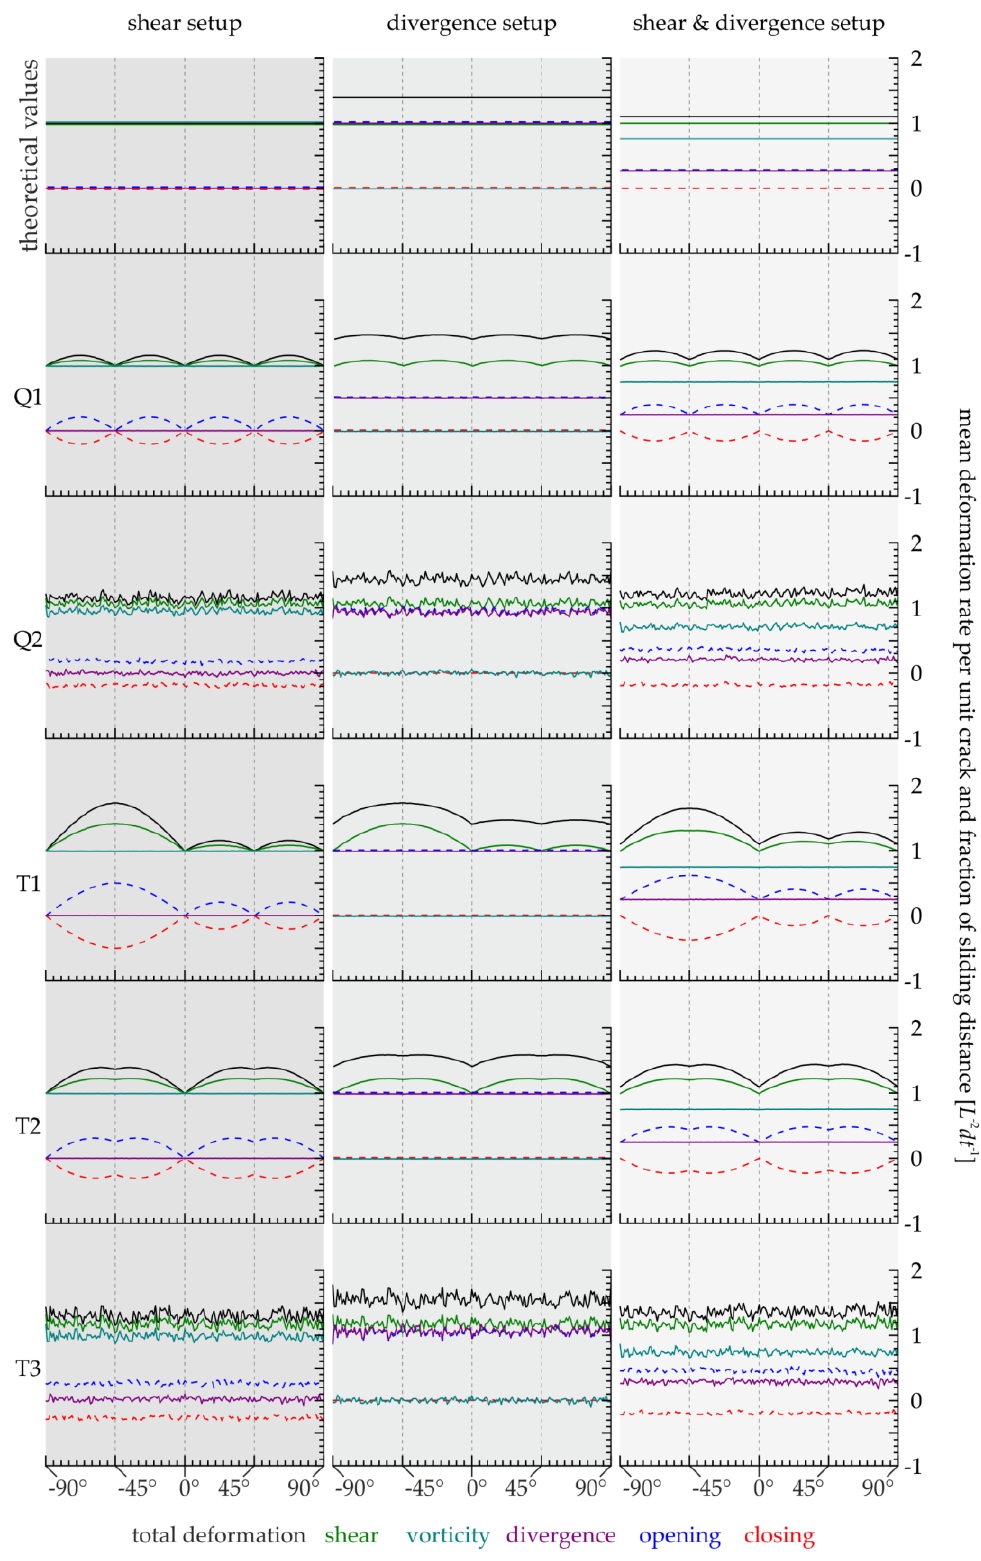
Figure 6. Mean deformation rate per unit crack and fraction of sliding distance for parameters total deformation, shear, vorticity, and divergence (including separation between opening and closing) as a function of the rotation angle. The corresponding theoretical rates are depicted in the uppermost plots.